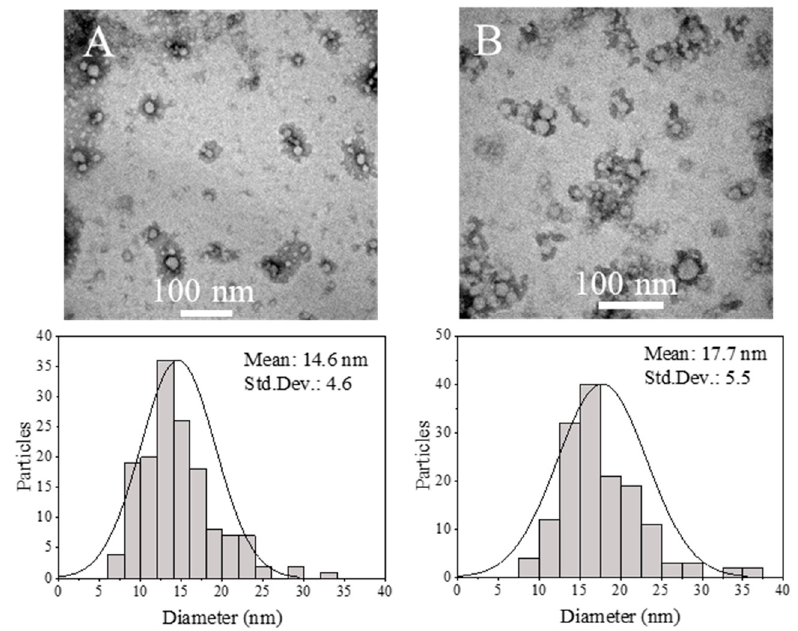
Figure 8. TEM micrographs and size distribution histograms of the synthesis polymer concentration of Eudragit ® RS100 5% (w/v), R (ASP/SP) value = 10: ( a ), 5 mL/min, ( b ) 50 mL/min.